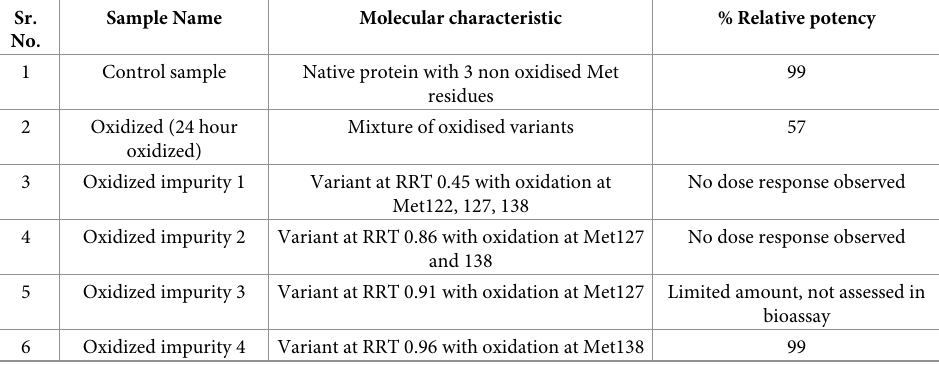
Table 5. Characterization of oxidized species (Under forced oxidation stress) RRTs are based on RP-HPLC reten- tion times relative to the main peak corresponding to the Native protein. Sr.